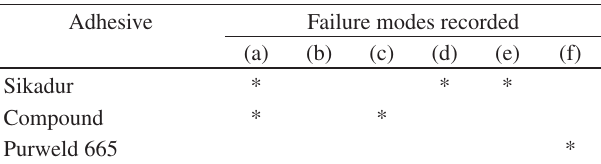
Table 2. Failure modes observed in fatigue tests – Pinus taeda.